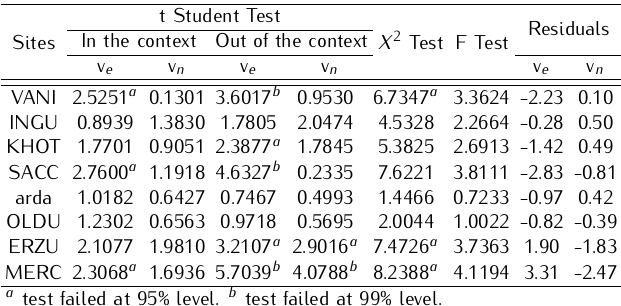
Table 4. Tests results (block B3). The results of the statistical tests for the GPS site data components. The sites passed from all the tests are the accepted data. The tests have been performed in two confidence levels (95% and 99%).